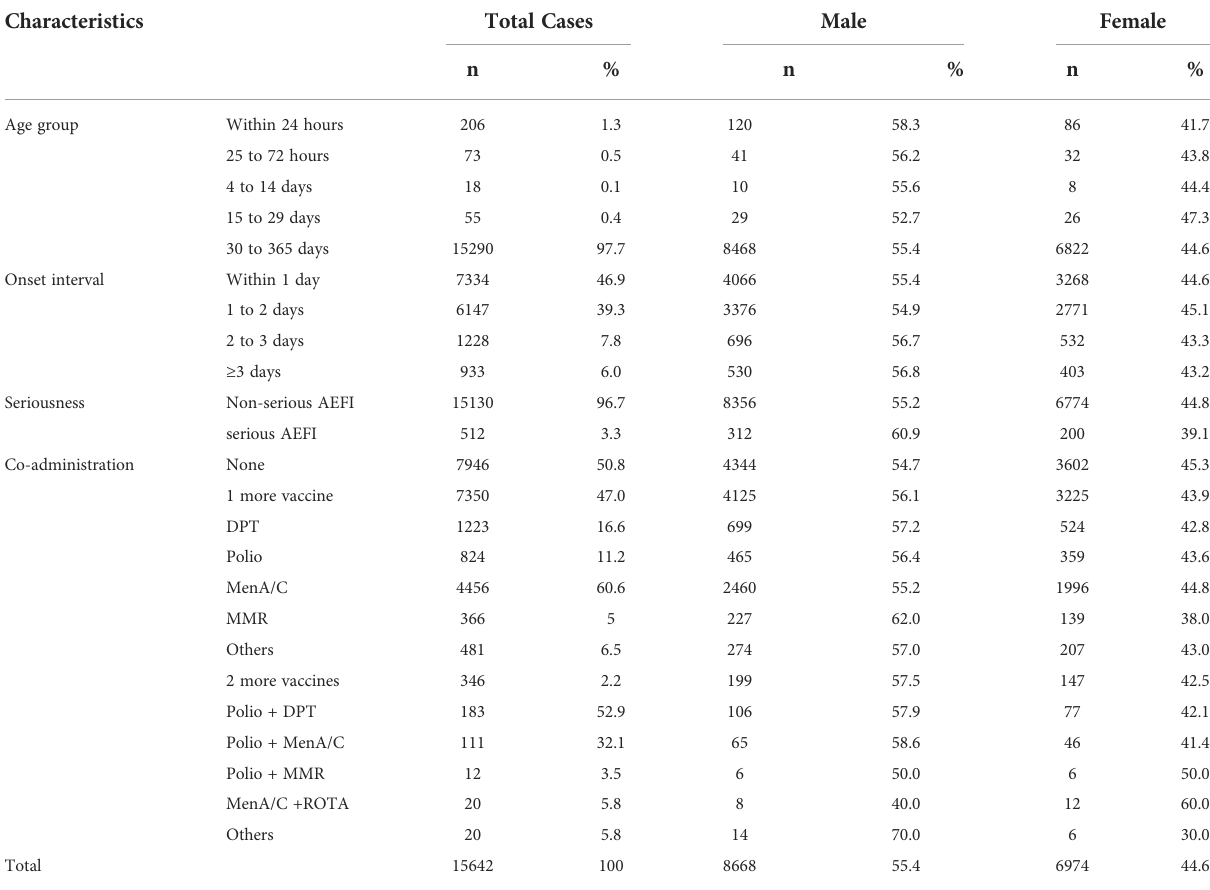
TABLE 2 Basic characteristics of the AEFI cases from